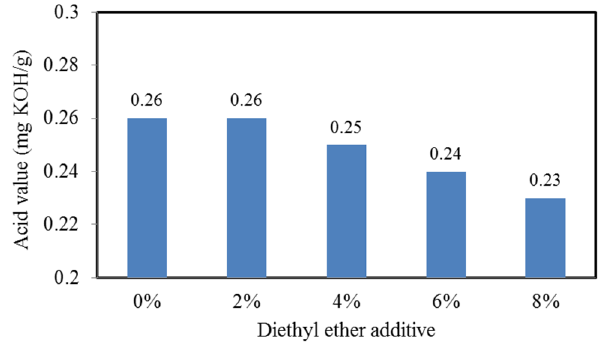
Figure 5. Effect of increasing diethyl ether percentage on blended B30 fuel acid value.